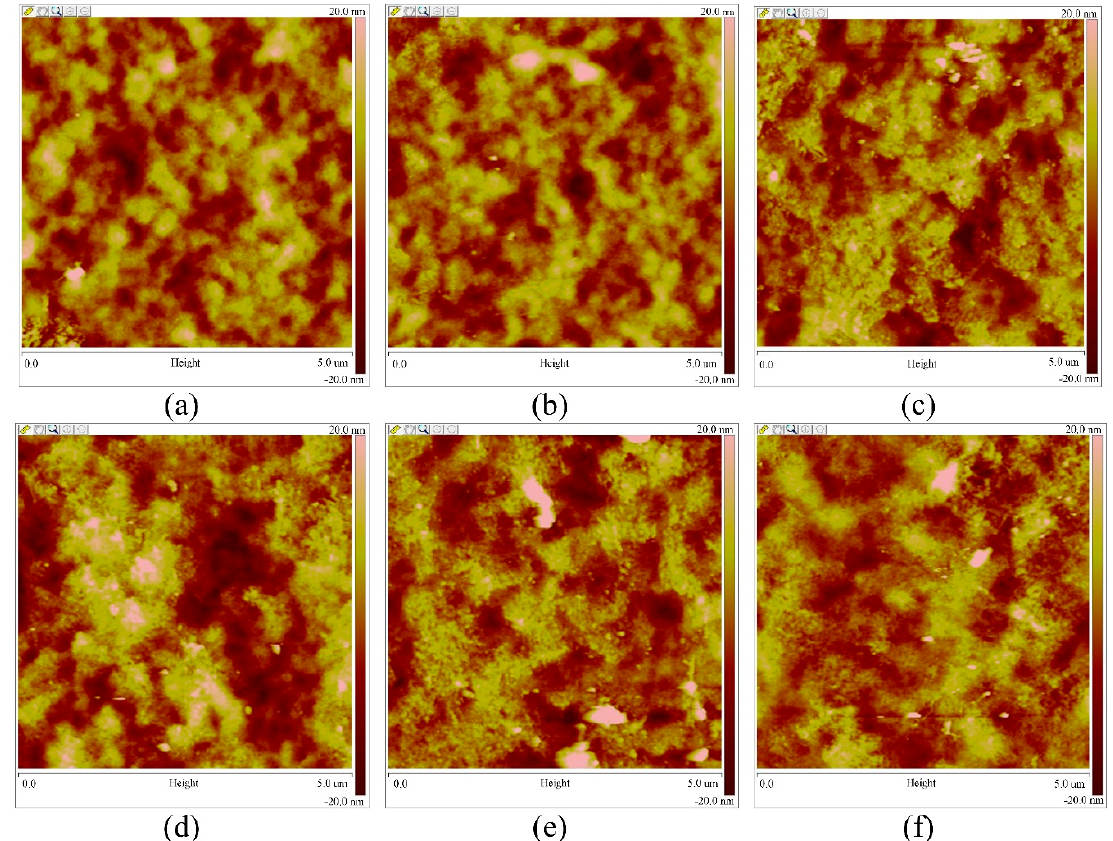
Figure 10. The atomic force microscopy (AFM) images of the direct-writing micro patterns with different process parameters. ( a ) A flow rate of 100 nL/min. ( b ) A flow rate of 150 nL/min. ( c ) A flow rate of 200 nL/min. ( d ) A flow rate of 250 nL/min. ( e ) A flow rate of 300 nL/min. ( f ) A flow rate of 350 nL/min.